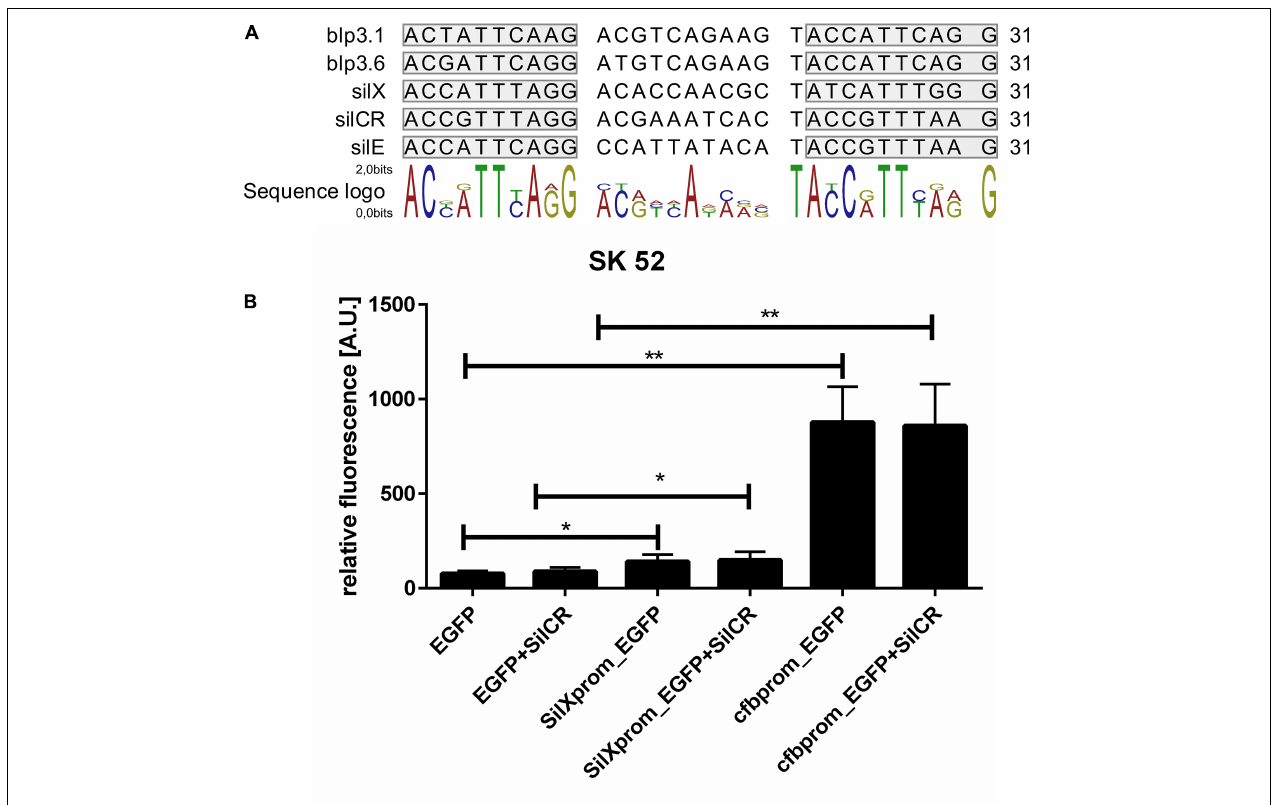
FIGURE 4 | Identification and activity of the SilX promotor. (A) Predicted SilA binding sites. Overview was constructed using CLC main workbench 7. Imperfect repeats are marked in gray. (B) Depicted is the mean fluorescence of S. anginosus SK52 (B) transformed with egfp without promoter (negative control), with the SilX promoter or the cfb promoter (positive control) either with or without 10 mg/l synthetic SilCR. Depicted are means + standard deviation of five independent experiments. Significant differences were calculated using a Man-Whitney U test with * illustrating a p -value < 0.5 and ** indicating p <